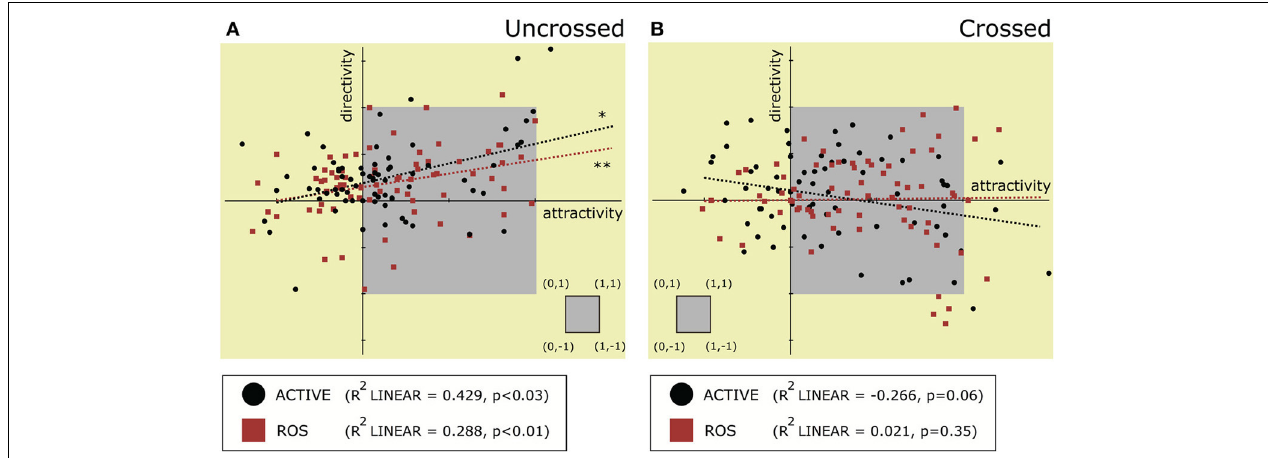
FIGURE 6 | Correlation diagram between attractivity and directivity in four types of hand postures. Diagram (A) depicts the condition when hands are uncrossed, and (B) that when hands are crossed. In the diagrams, each small black dot represents data from the Active condition, and each red